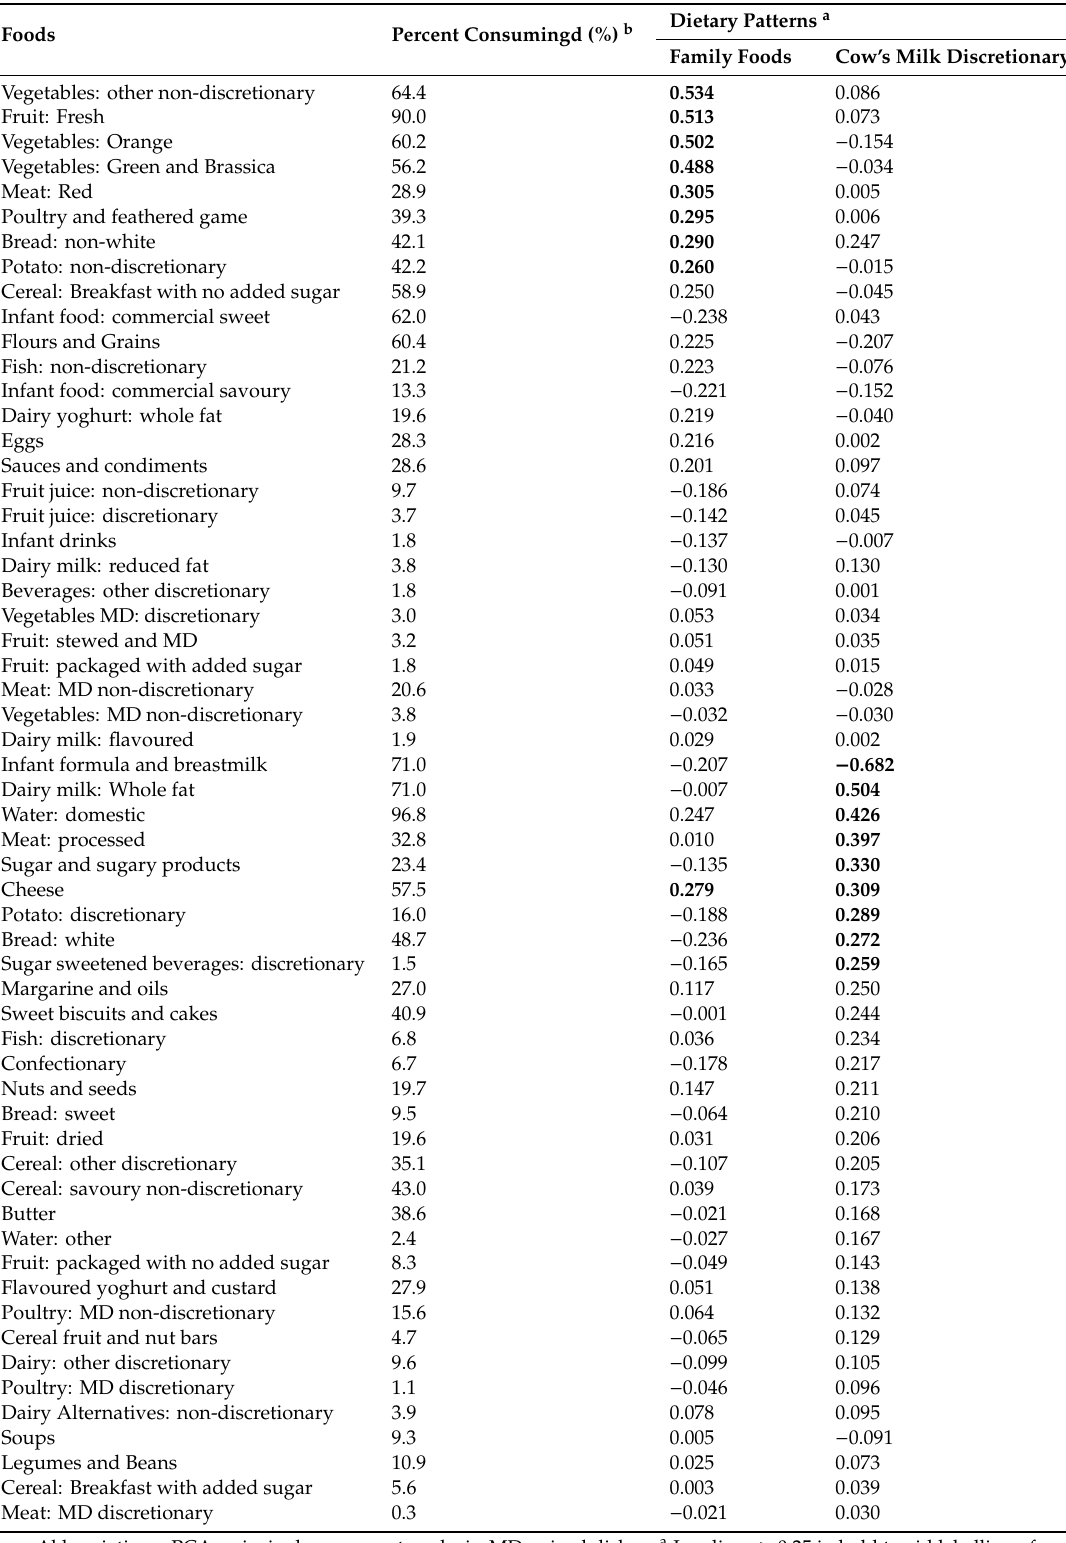
Table 2. Varimax-rotated food group loadings on each of the dietary patterns at 12 months extracted by Principal Components Analysis